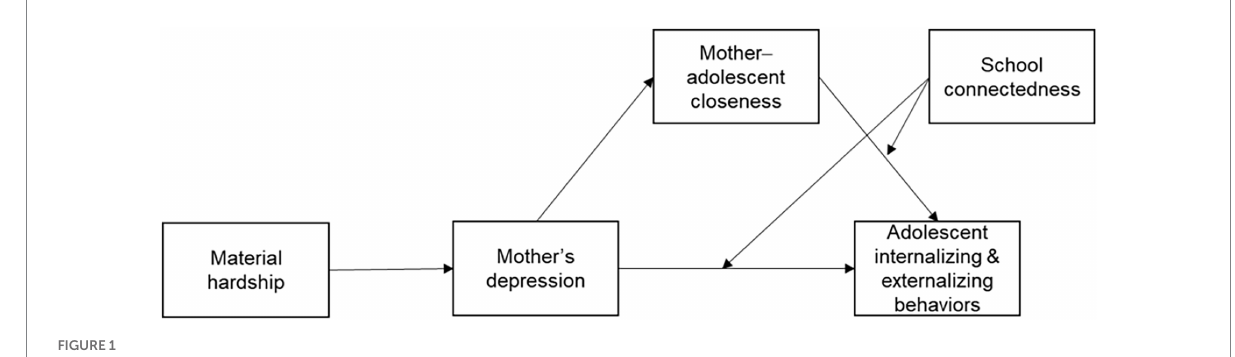
FIGURE 1 Research model.